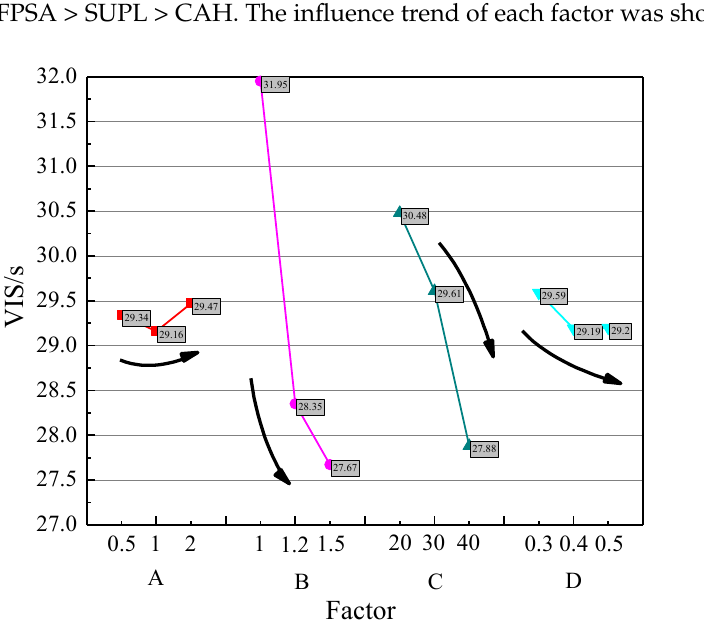
Figure 3. Trend chart of the influence of various factors on VIS. The analysis of Figure 3 and Table 6 indicates that increasing the amount of CAH added had little effect on the VIS of the cement-based slurry. When the amount of CAH added was 0.5%, the VIS of the slurry was 29.34 s. When the dosage of CAH was increased to 2%, the VIS of the slurry was 29.47 s, the growth rate was 1.4% and its influence could be ignored. The impact of WCR on the VIS of the ultrafine cement-based slurry was significant, the VIS gradually decreased with the increase of WCR. When the WCR was 1.0, 1.2 and 1.5, the VIS of the slurry was 31.95 s, 28.35 s and 27.67 s, respectively. The change rates were 11.27% and 2.40%, respectively. It is due to the fact that the water is added, then, as its fluidity is higher, it increases the fluidity of the slurry, hence reducing the VIS [23]. The VIS of an ultrafine cement-based slurry can be slightly reduced by increasing the amount of SUPL added. When the content of SUPL rose from 0.3% to 0.5%, the slurry VIS decreased by 0.40 s. It can be seen from the literature [24] that SUPL can change the surface characteristics of cementitious material particles. On the one hand, it can disperse solid particles; on the other hand, it can destroy the flocculation-like structure in the slurry so that the encapsulated flocculation water is released and the slurry is free. The VIS of the slurry decreased with increasing water. Due to the addition of FPSA, the VIS of the cement slurry was reduced. The larger the amount of FPSA added, the smaller the VIS of the cement slurry. When the content of FPSA increased to 40%, the VIS of the slurry decreased by 2.60